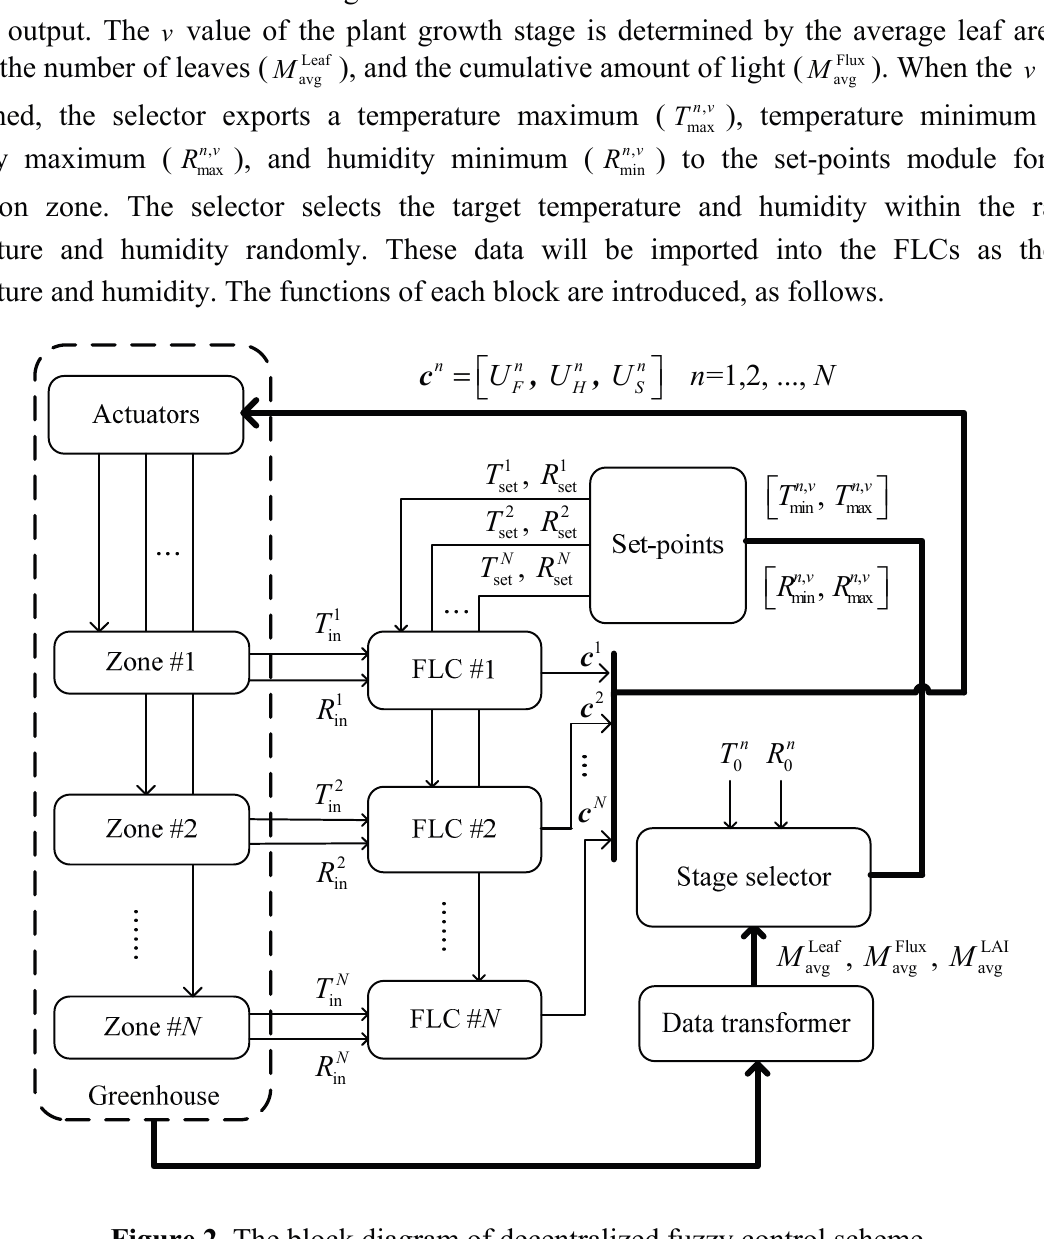
Figure 2. The block diagram of decentralized fuzzy control